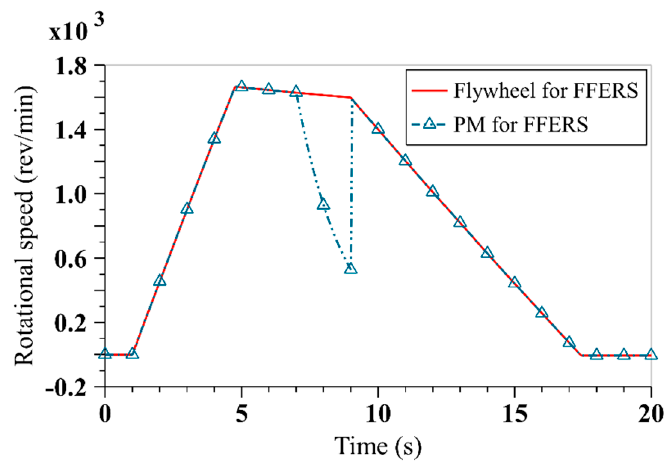
Figure 16. The rotational speeds of the flywheel and PM of the FFERS.